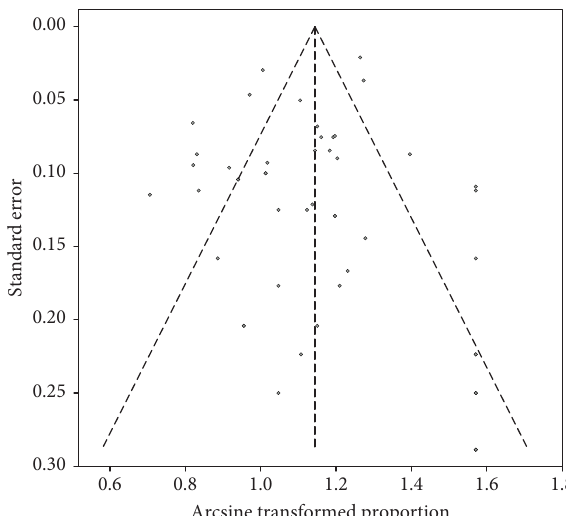
Figure 3: Funnel plot of publication bias of gastrointestinal